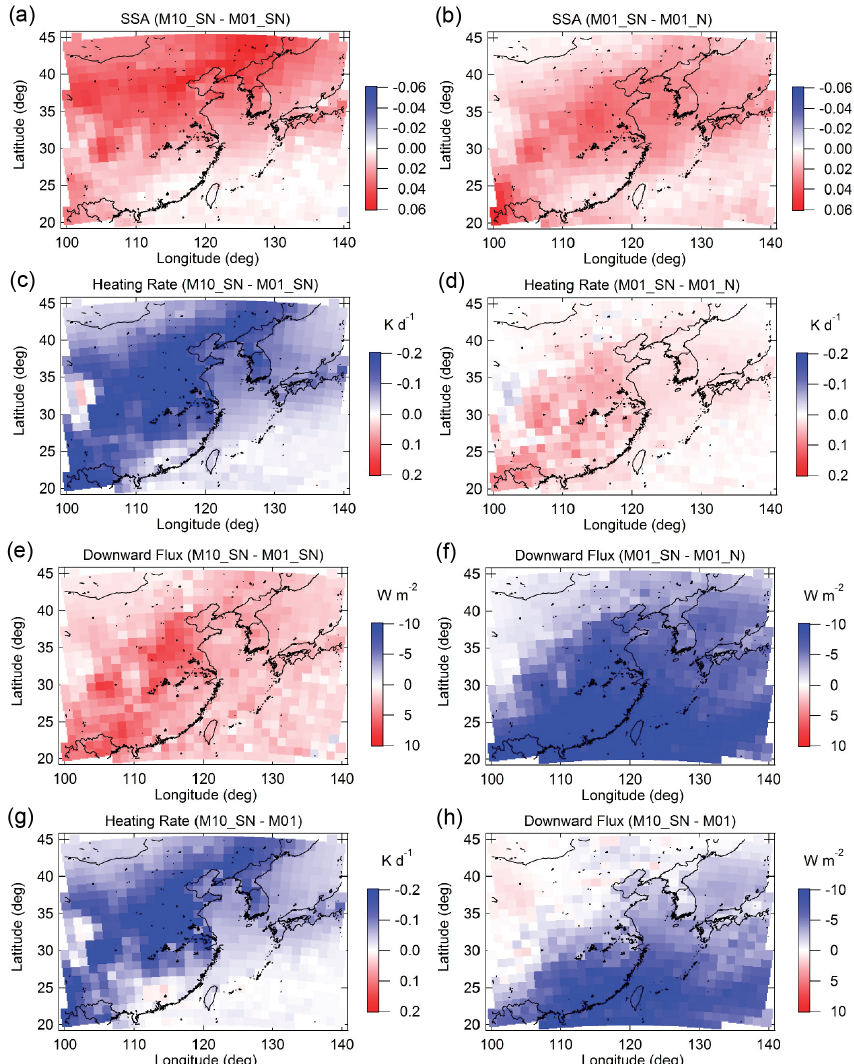
Figure 9. The period-averaged impacts of (left panels) BC aging and (right panels) SOA on SSA at 1km ( a and b ), the heating rate by aerosols at 1km ( c and d ), and the change in the downward solar flux by aerosols at the surface ( e and f ). The contributions of BC aging and SOA are estimated from the difference between the M10_SN and M01_SN simulations and between the M01_SN and M01 simulations, respectively. In the bottom two panels, the combined effects of BC aging and SOA (the difference between the M10_SN and M01 simulations) are also shown for (g) the heating rate by aerosols and (h) the change in the downward solar flux by aerosols at the surface. The period-averaged values are calculated offline using the data at 12:00 LT (03:00 UTC) between 24 March and 26